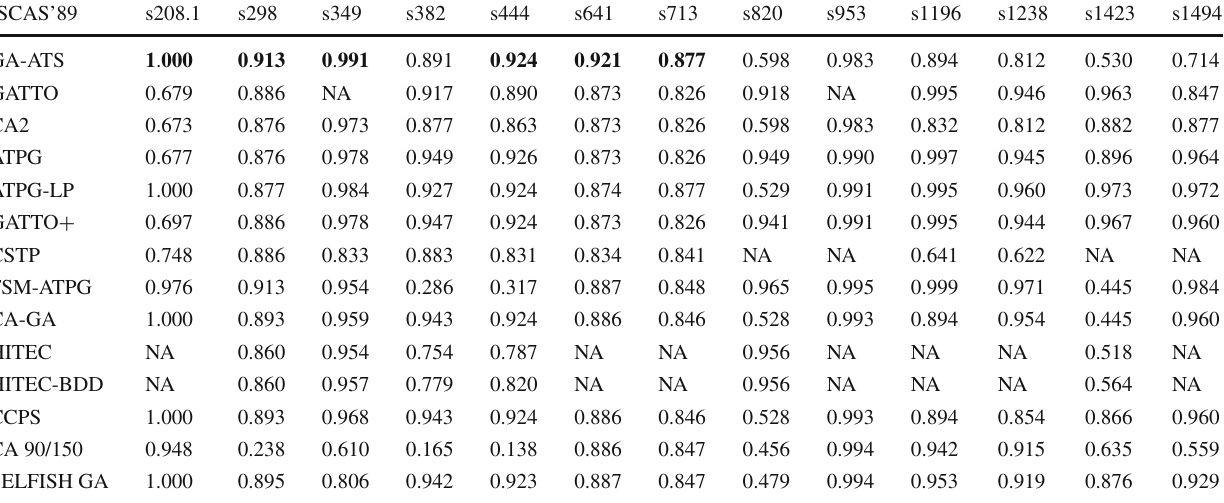
Table 3 ISCAS’89 benchmark fault coverage results